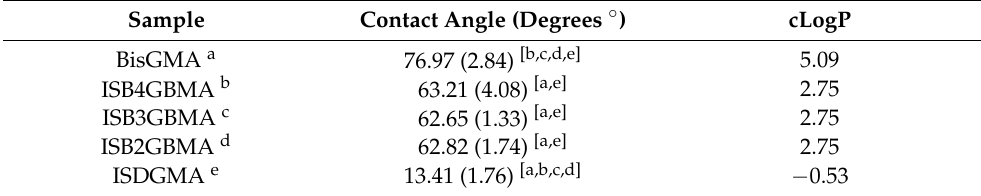
Table 1. Contact Angle Measurements and cLogP Estimations of BisGMA, ISB4GBMA, ISB3GBMA, ISB2GBMA, and